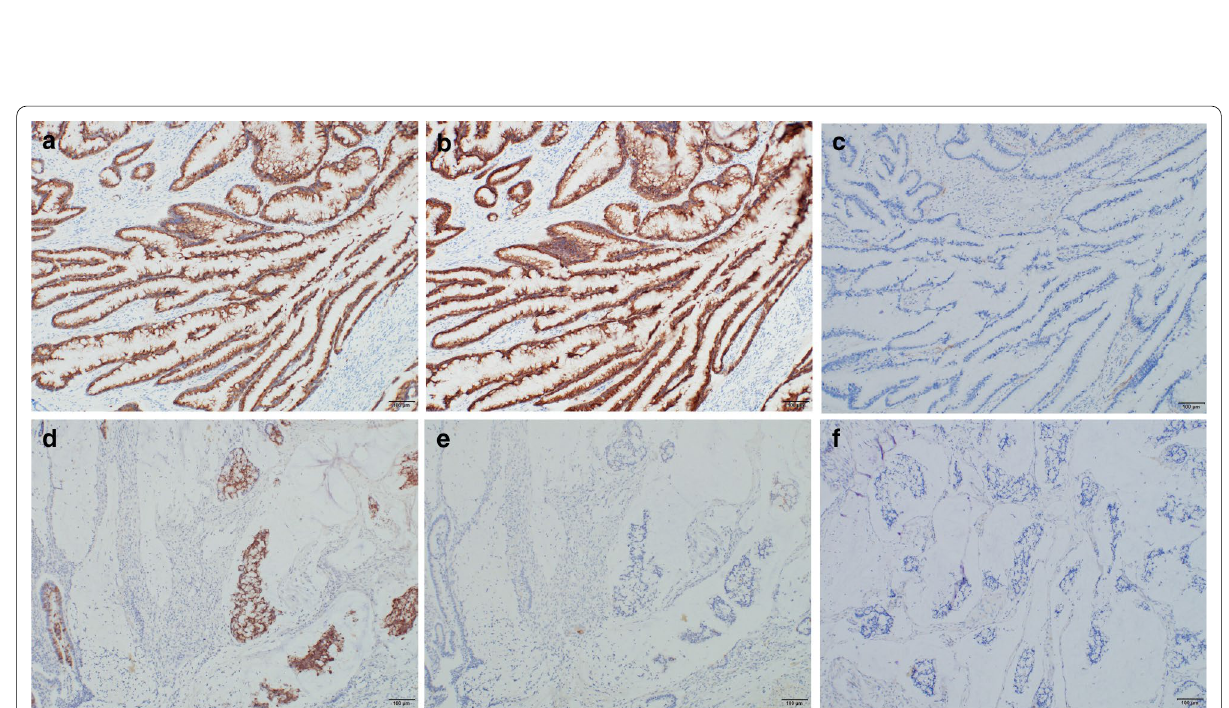
Fig. 6 Immunostaining for the mucinous phenotype. Immunostaining showed positive findings for a MUC2, b MUC5AC, and negative finding for c CD10 in the papillotubular tumor site. On the other hand, d positive MUC2, e negative MUC5AC, and f negative CD10 were revealed at the mucinous adenocarcinoma